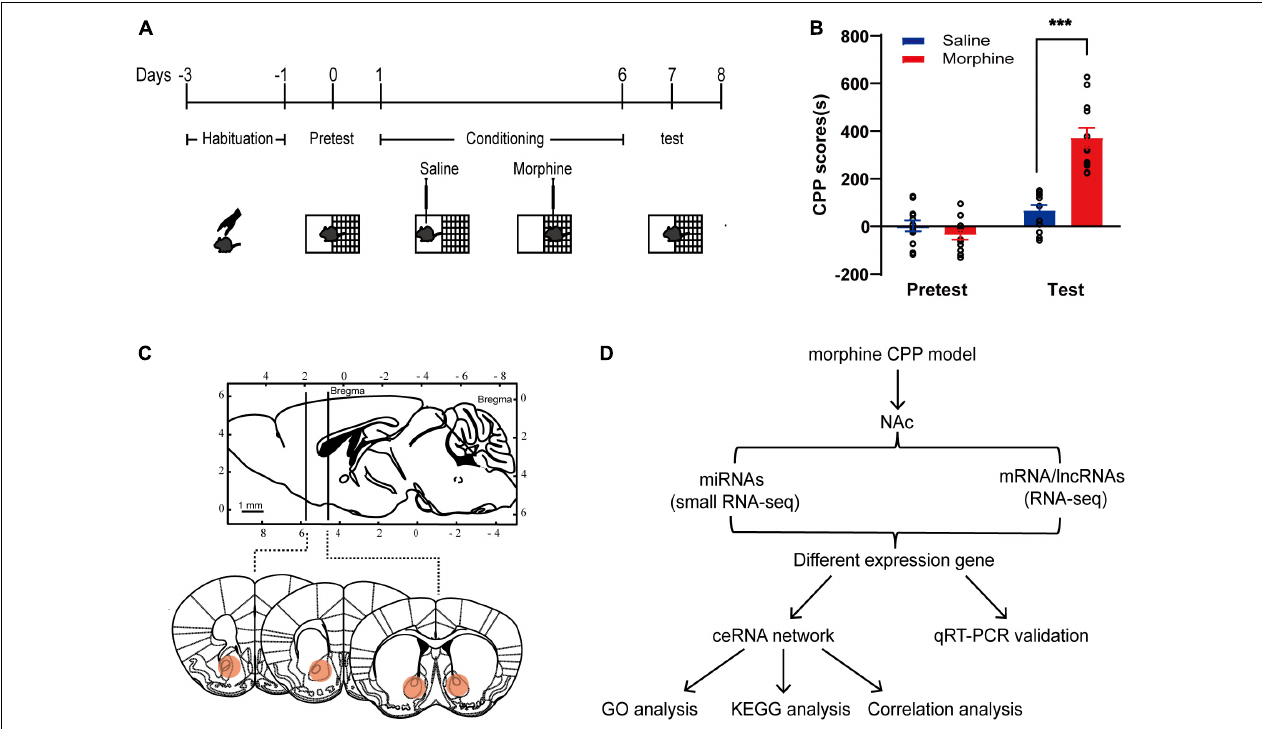
FIGURE 1 | Establishment of the morphine CPP model. (A) Chematic experimental design for the training and test of morphine-CPP. (B) CPP scores of saline- and morphine-treated mice on Days 0 and 7. The data are presented as the mean ± SEM, n = 12, *** p < 0.001, compared with the saline group. (C) Up: The position of the razor blades used to cut the nucleus accumbens (NAc) are shown in a sagittal section of the mouse brain; down: Schematic illustrations of NAc location in coronal slices (red area). (D) Flowchart for the identification and analysis of ncRNAs and mRNAs in the ceRNA network.